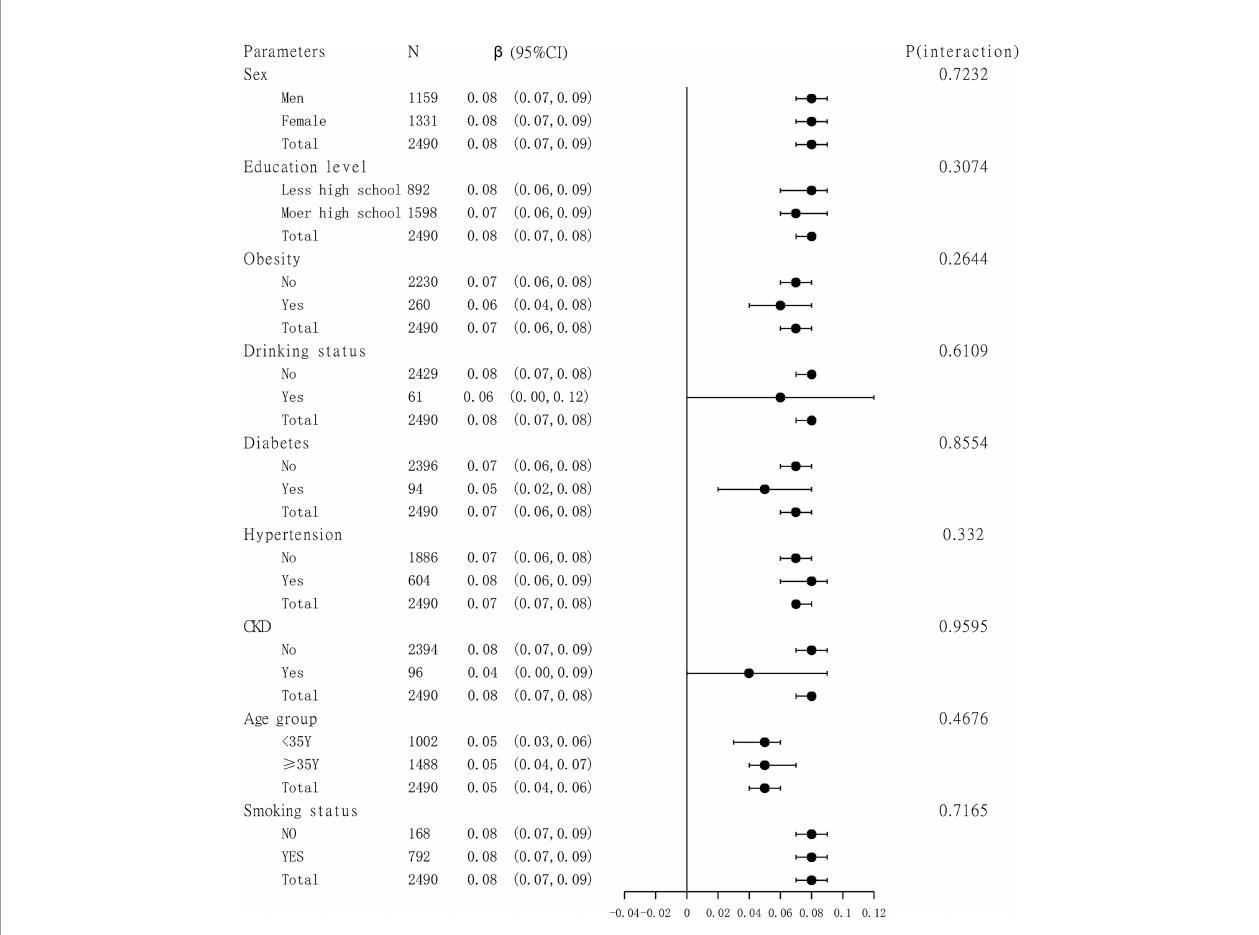
FIGURE 3 | Subgroup analysis. TBil, AST, ALP, GGT, ALT, TC, TG, HDL-C, and LDL-C were